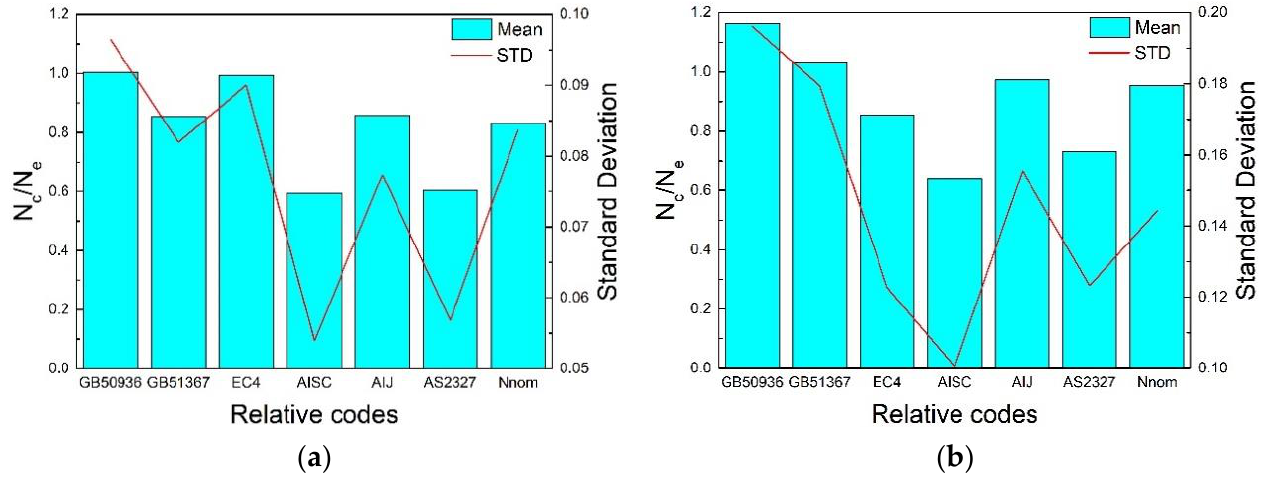
Figure 17. Comparison of specific values and standard deviation. ( a ) stub columns; ( b ) medium long and long columns.